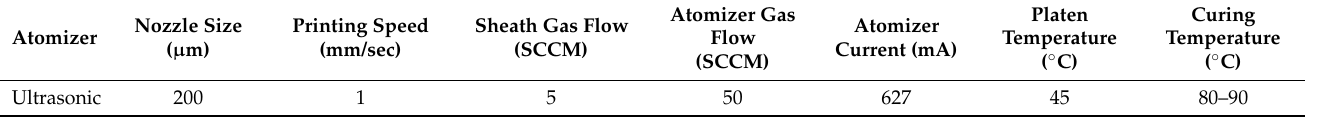
Table 3. The summary of the printing parameters for PVA deposition with ultrasonic